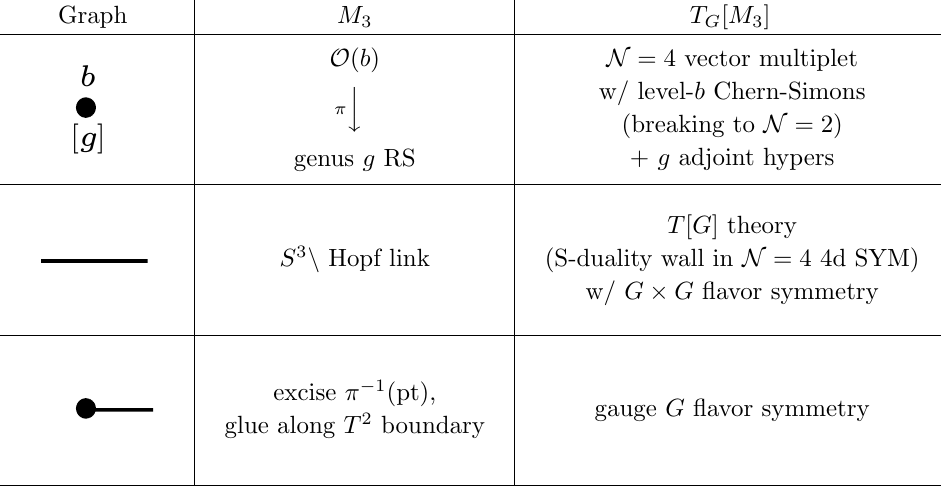
Table 2 . The rules for plumbing graphs. O ( b ) denotes a circle bundle with Chern class b .